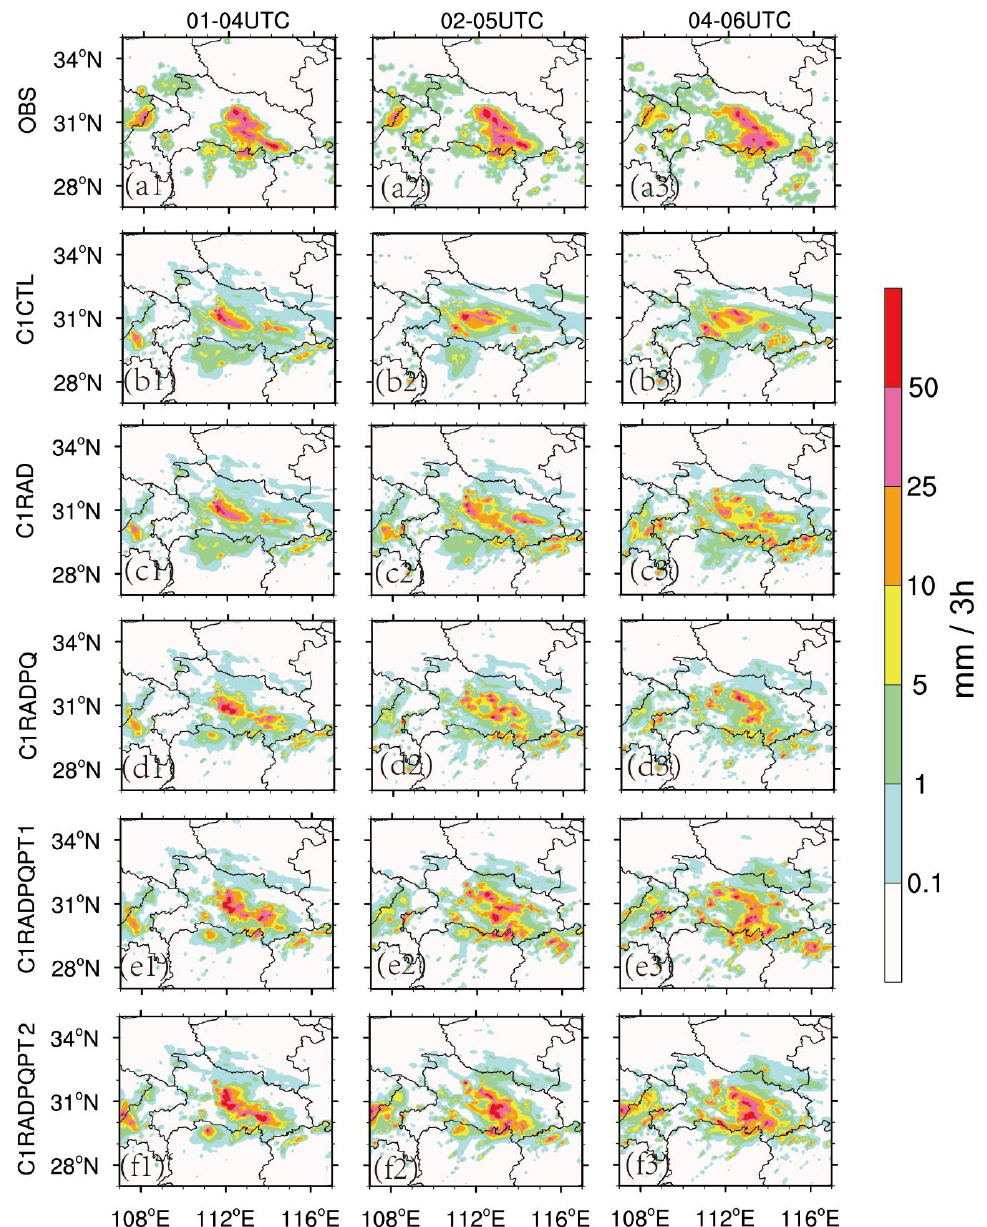
Figure 8. Plots of observed 3-h accumulated precipitation( a1 – a3 ) and corresponding forecasts start from 0100 UTC (left panel), 0200 UTC (middle panel), and 0300 UTC (right panel) for the ( b1 – b3 ) C1CTL, ( c1 – c3 ) C1Rad, ( d1 – d3 ) C1RadPQ, ( e1 – e3 ) C1RadPQPT1, and ( f1 – f3 ) C1RadPQPT2 experiments.